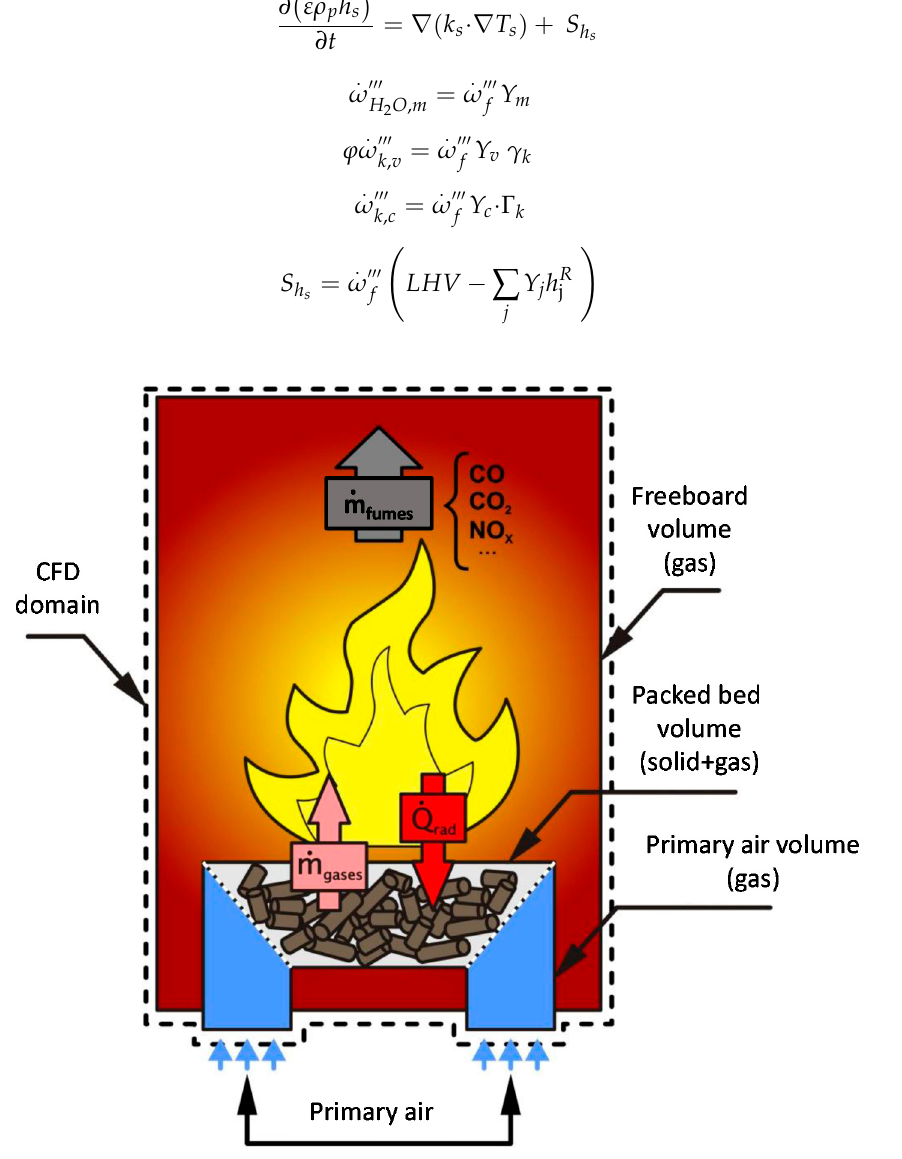
Figure 1. Representation of the combustion approach.